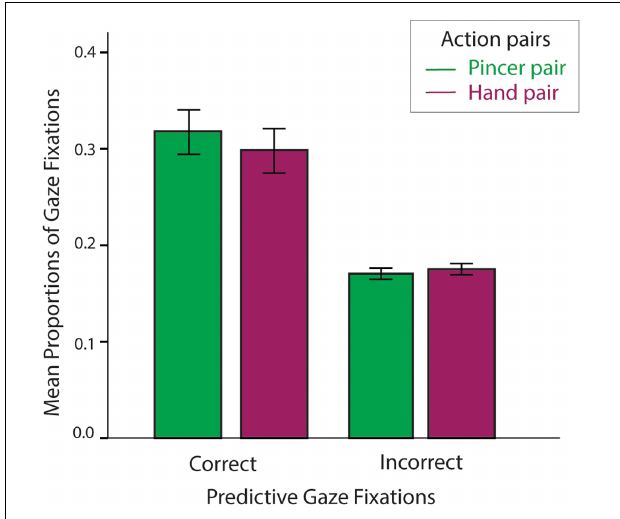
FIGURE 3 | The mean proportions of correct and incorrect gaze fixations collapsed across motor groups. Bars represent standard errors of the mean.